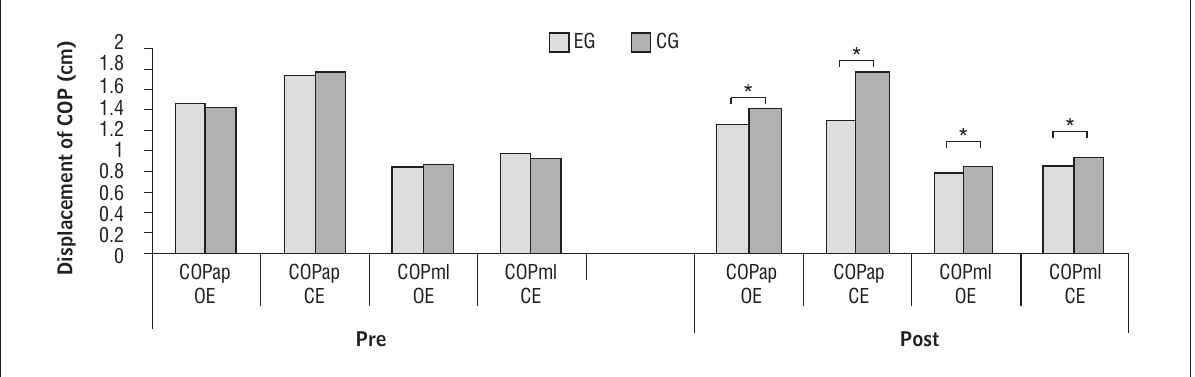
Figure 2 - Results related to the comparison between groups (EG x CG) in pre and post-training, in both visual conditions (OE and CE), for both variables analyzed (COPap and COPml)